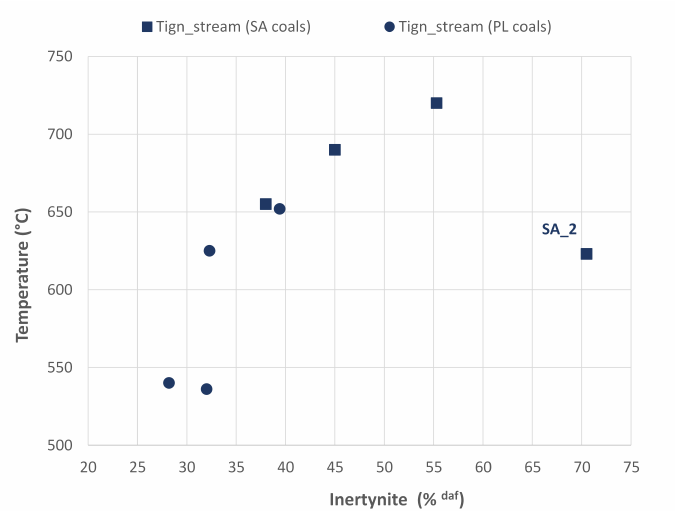
Figure 7. Effect of inertinite content of coals on the dispersed coal–particle stream ignition tempera- ture, T stream ign